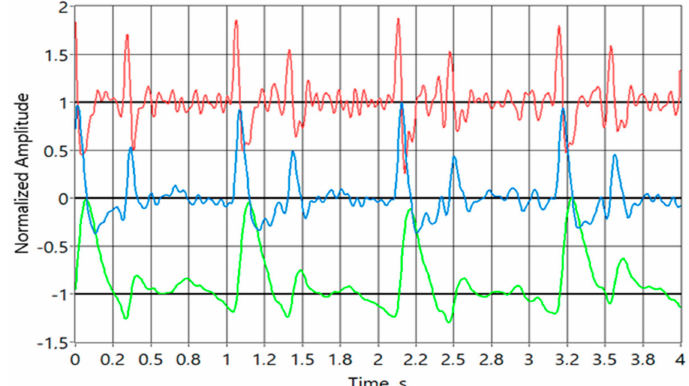
Figure 15. Bioimpedance signal, acquired with derivative technology, shown on Figure 11. All curves are normalized. Blue curve in the middle is the actual signal from the device, i.e., first derivative of the bioimpedance signal, upper red curve is second derivative of the bioimpedance signal shifted up by 1 unit, and lower green curve is integral of the incoming signal shifted down by 1 unit. It is also the actual bioimpedance